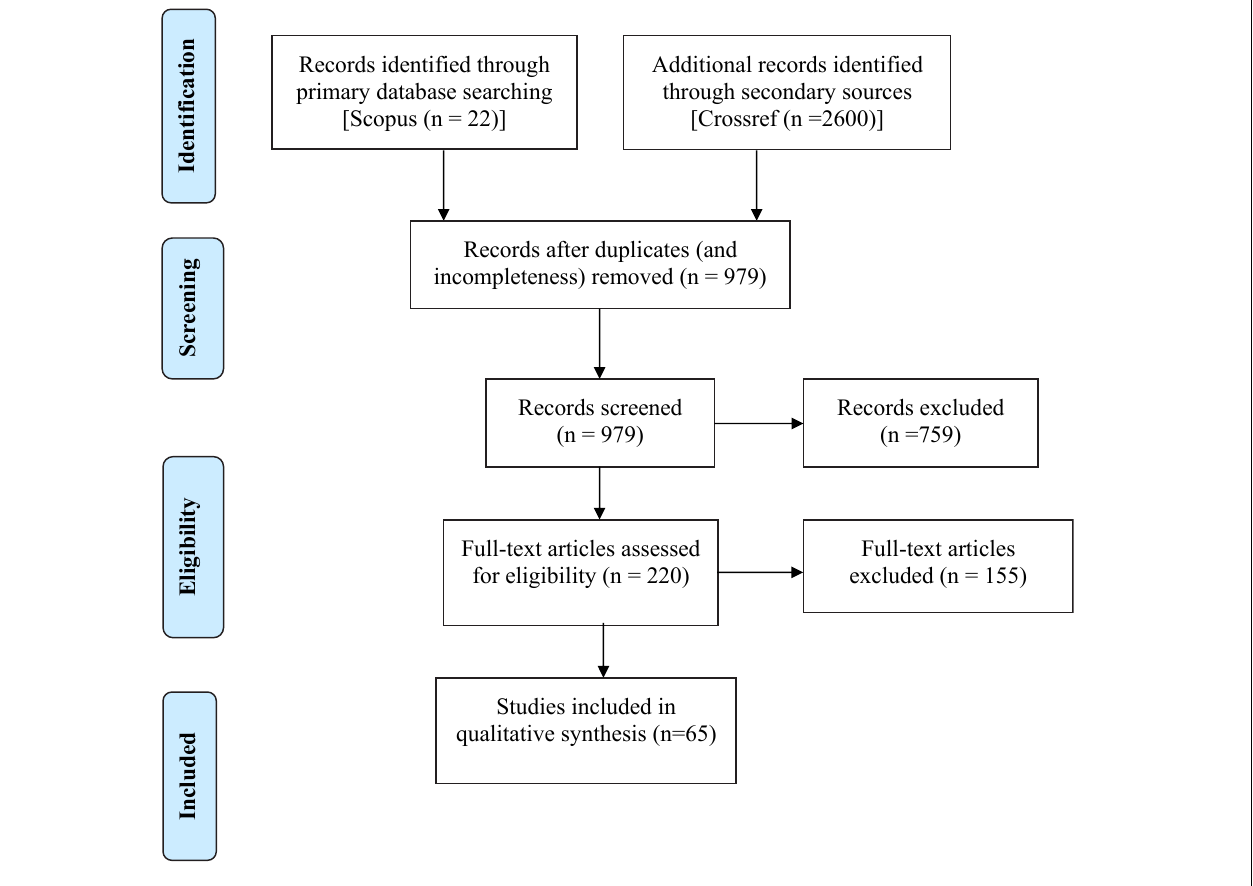
FIGURE 1 | Summary of studies inclusion and exclusion based on PRISMA guidelines. Adapted from Moher et al. (2009).